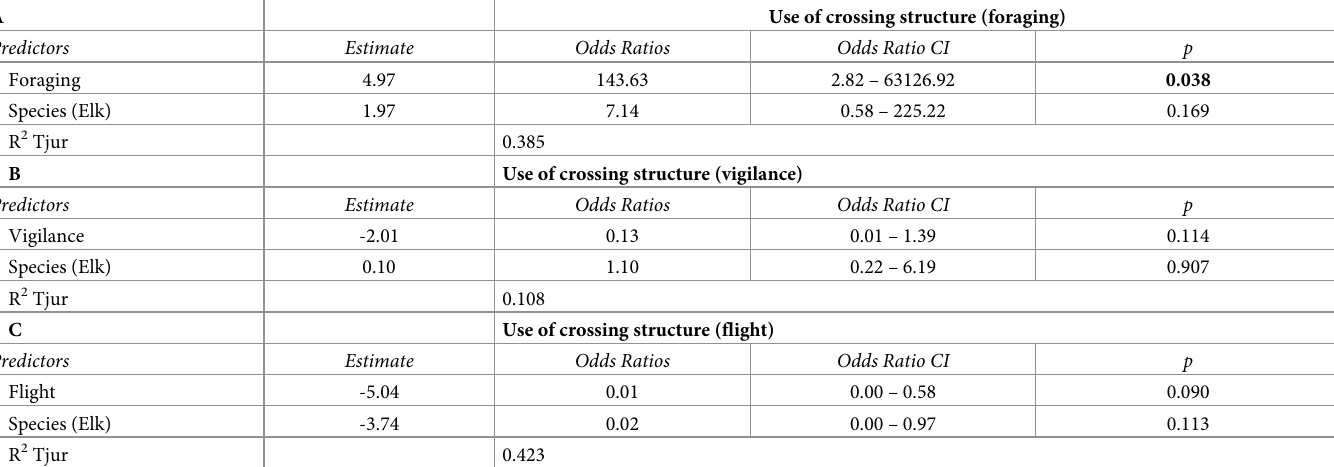
Table 2. Model results from logistic regression of mitigation structure use and behavioral response to vehicles. Logistic regression results—probability of elk and deer crossing a road, using a wildlife underpass, as a function of species identity and the change in the proportion of time allocated to A) foraging; B) vigilance (standing and looking); and C) flight before vehicle passage compared to the proportion of time allocated after vehicle